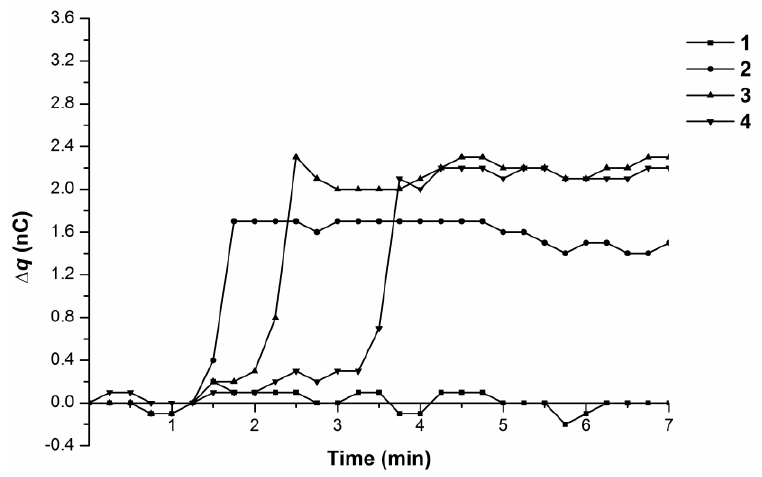
Figure 5. Time dependence curves of charge accumulation ∆q(t) upon water influx from the tip in the flow-through system at 38 °C. Curves 1–4 represent parallel measurements of one and the same experimental series.